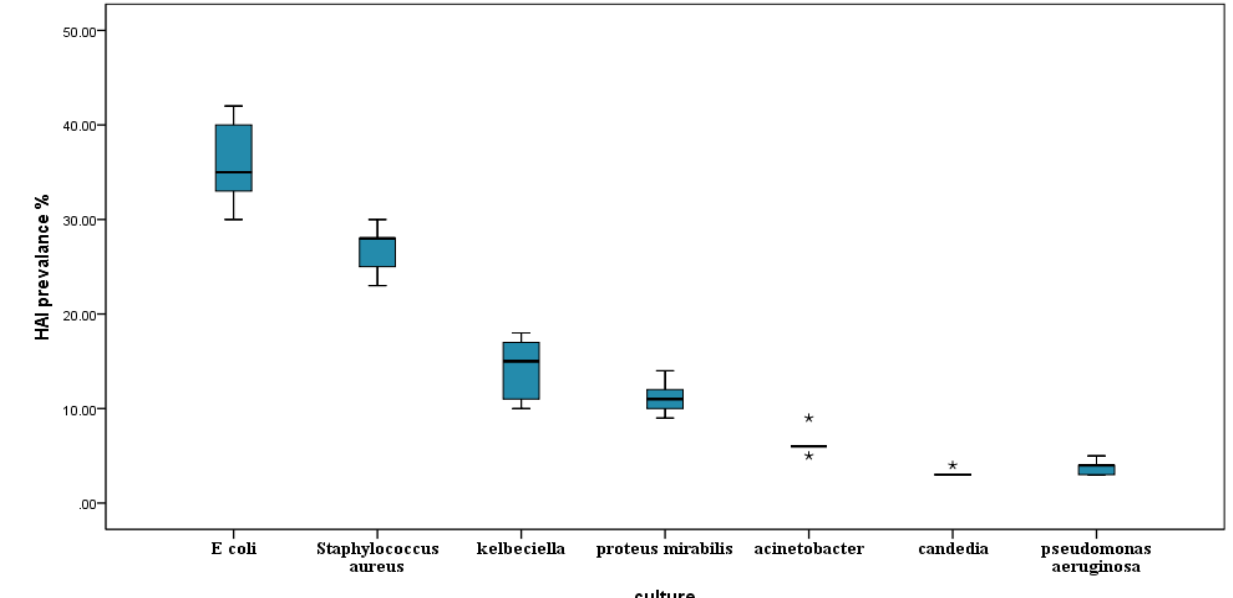
Figure 2. Box plot graph depicting hospital-acquired infection (HAI) prevalence based on the type of